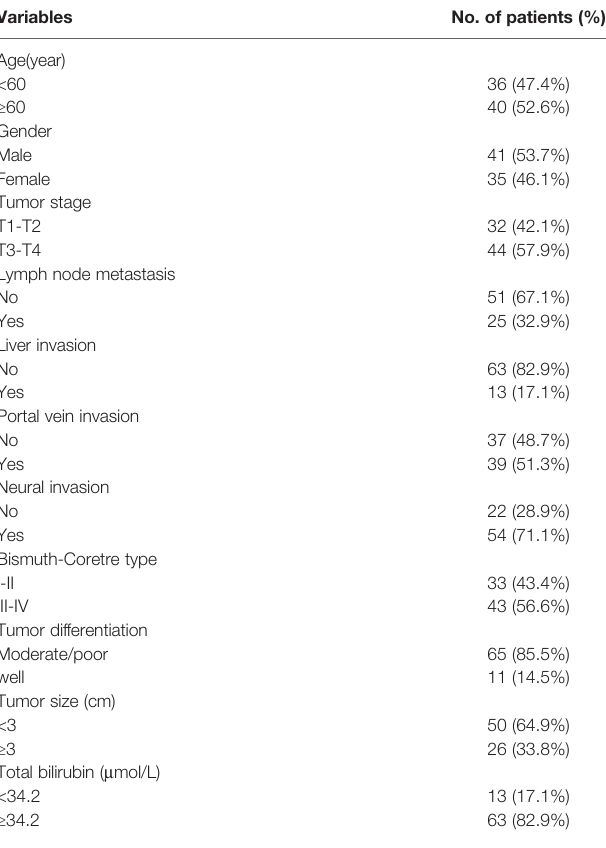
TABLE 1 | Baseline